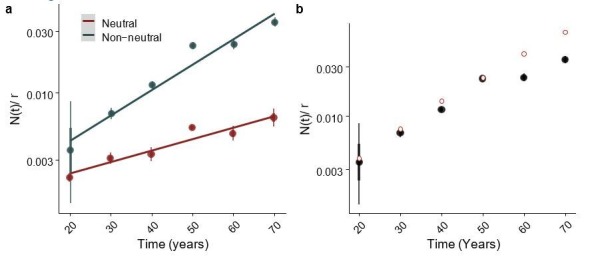
Fitted parameter values of a simulated dataset as a function of time.(a) Inferred N(t) as a function for age in a simulated cohort, equivalent to Figure 5D. (b) Posterior estimates for inferred values in black, with ground truth shown with red circular points, for this “ground truth” we calculated N(t) using Δ=0.05, the mean of the exponential distribution used in the simulations..